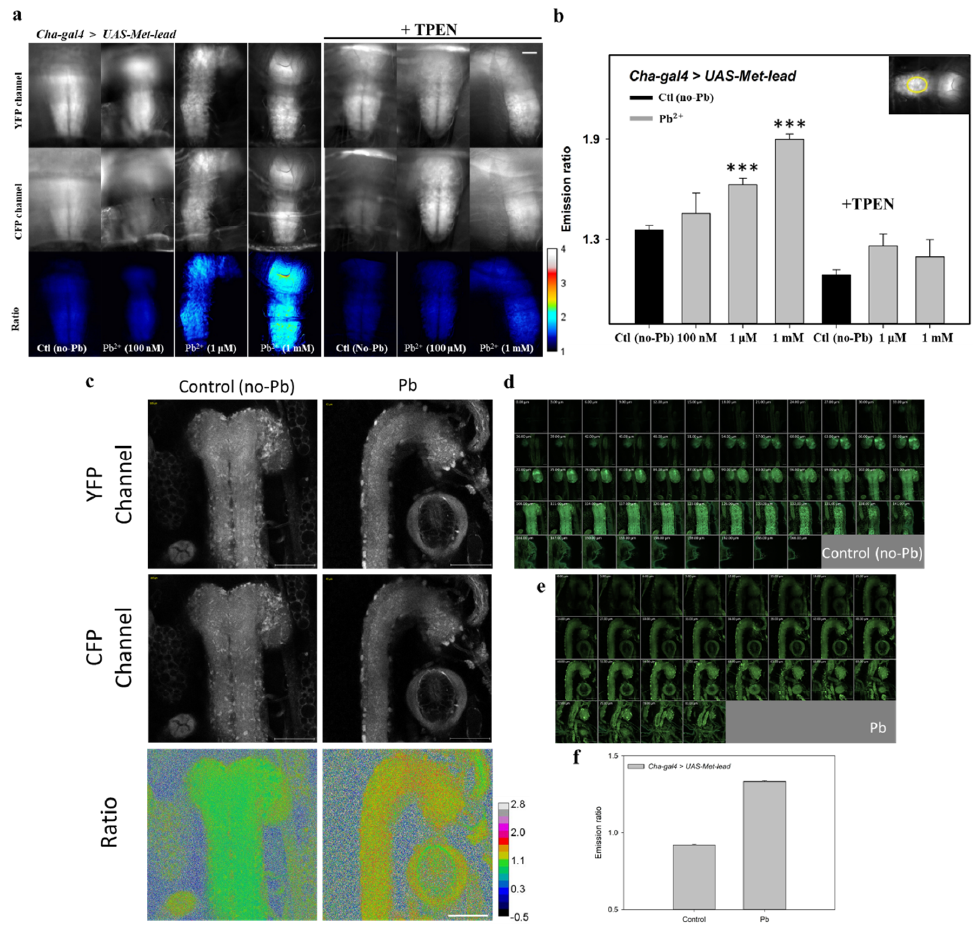
Figure 5. Application of Met-lead to the central nervous systems (CNSs) of Drosophila larvae using a fast epi-fluorescent ( a , b ) or two-photon ( c – f ) FRET imaging system. ( a ) Images of intact